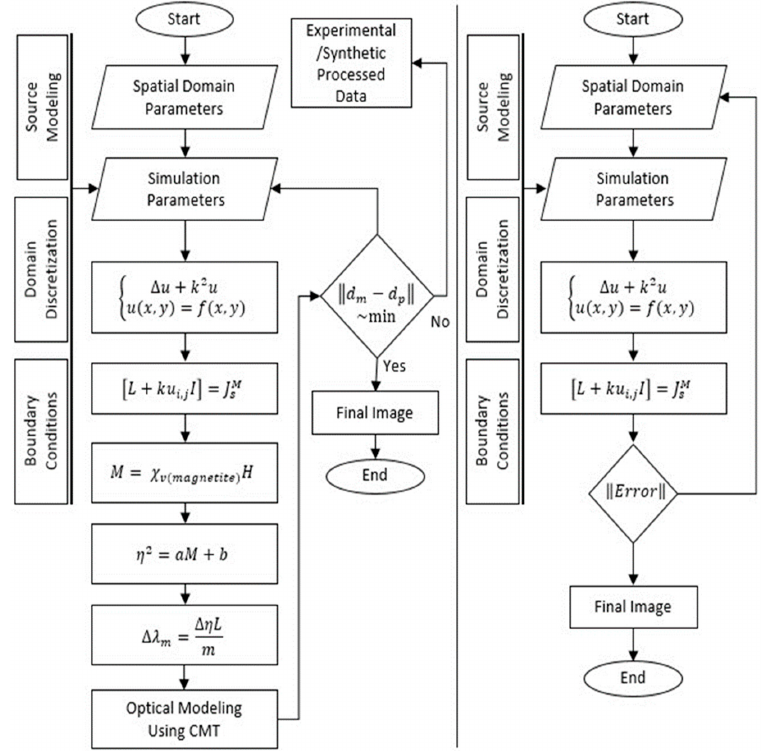
Figure 3. Flow diagram for inversion of optical data using iterative algorithm.